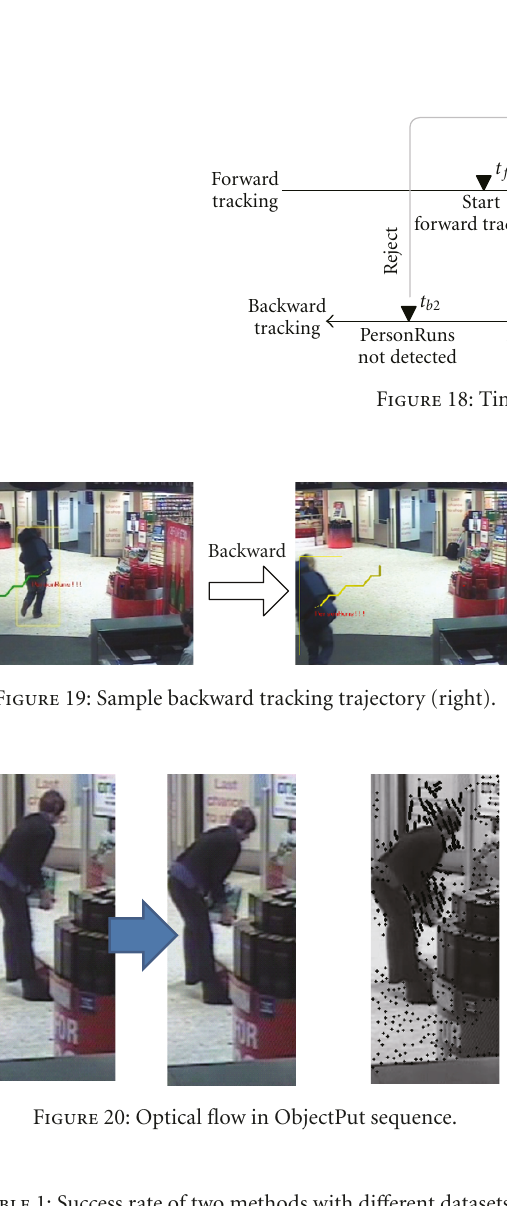
Table 1: Success rate of two methods with di ff erent datasets. KTH